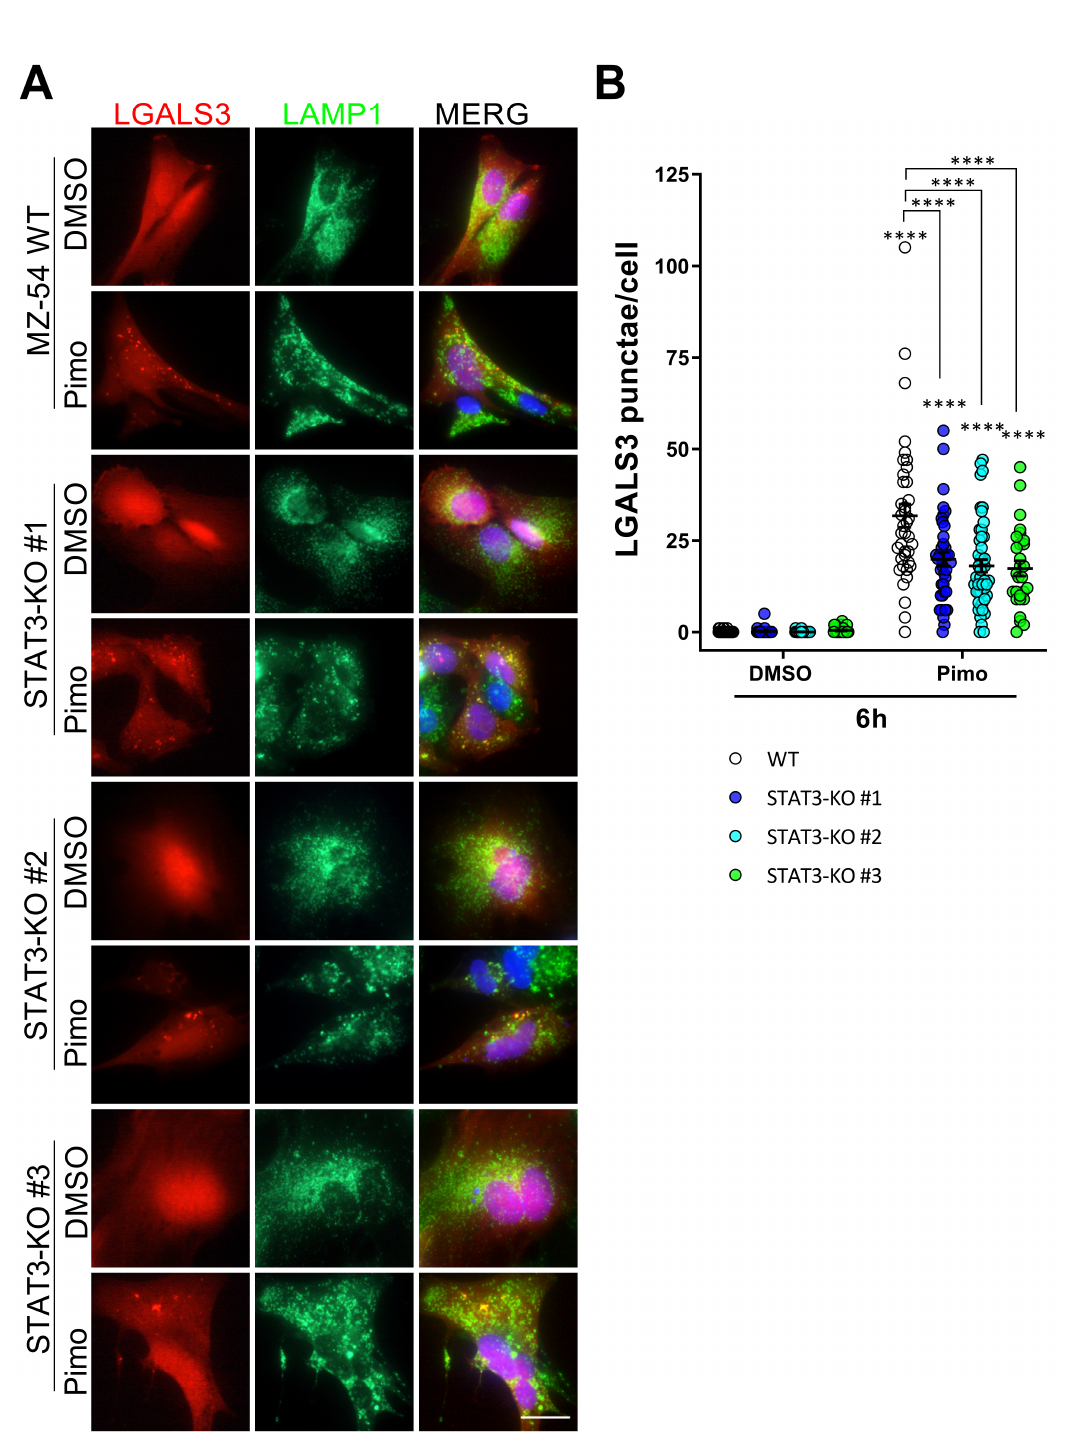
Figure 5. Depletion of STAT3 reduces lysosomal membrane permeabilization and release of lysosomal content. ( A ) Representative pictures of stably transfected MZ-54 WT and STAT3-KO cells expressing LGALS3-mCherry and co-stained against the lysosomal marker LMAP1 after treatment with 25 μ M Pimozide (Pimo) or vehicle (DMSO) for 6 h. Note that MZ-54 WT cells exhibit more yellow punctae in the merged view indicating LMP. ( B ) Quantification of LGALS3-punctae of cells treated as in ( A ) depicted as point plots of three experiment of which at least 3 vision fields were counted (in total 29 to 48 cells per condition). **** p > 0.0001; Two-Way ANOVA with Tukey’s multiple comparison test (GraphPad Prism